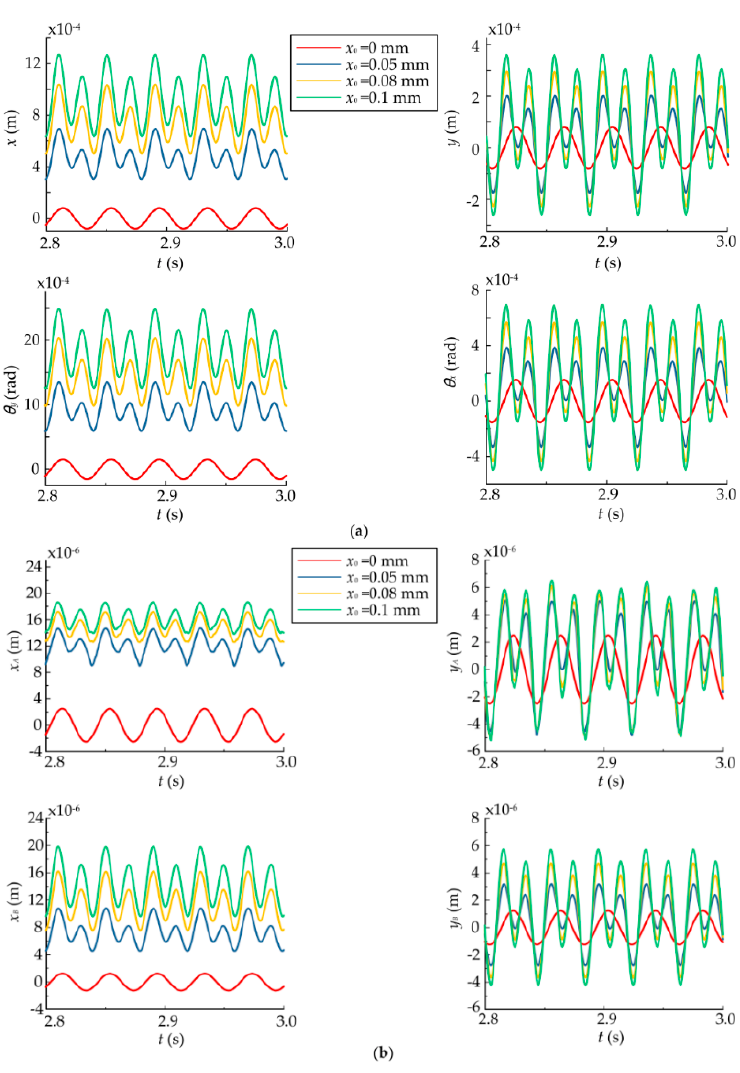
Figure 7. Time history of the dynamic responses for different eccentricities. ( a ) Time history of rotor dynamic responses; ( b ) Time history of bearing dynamic responses.